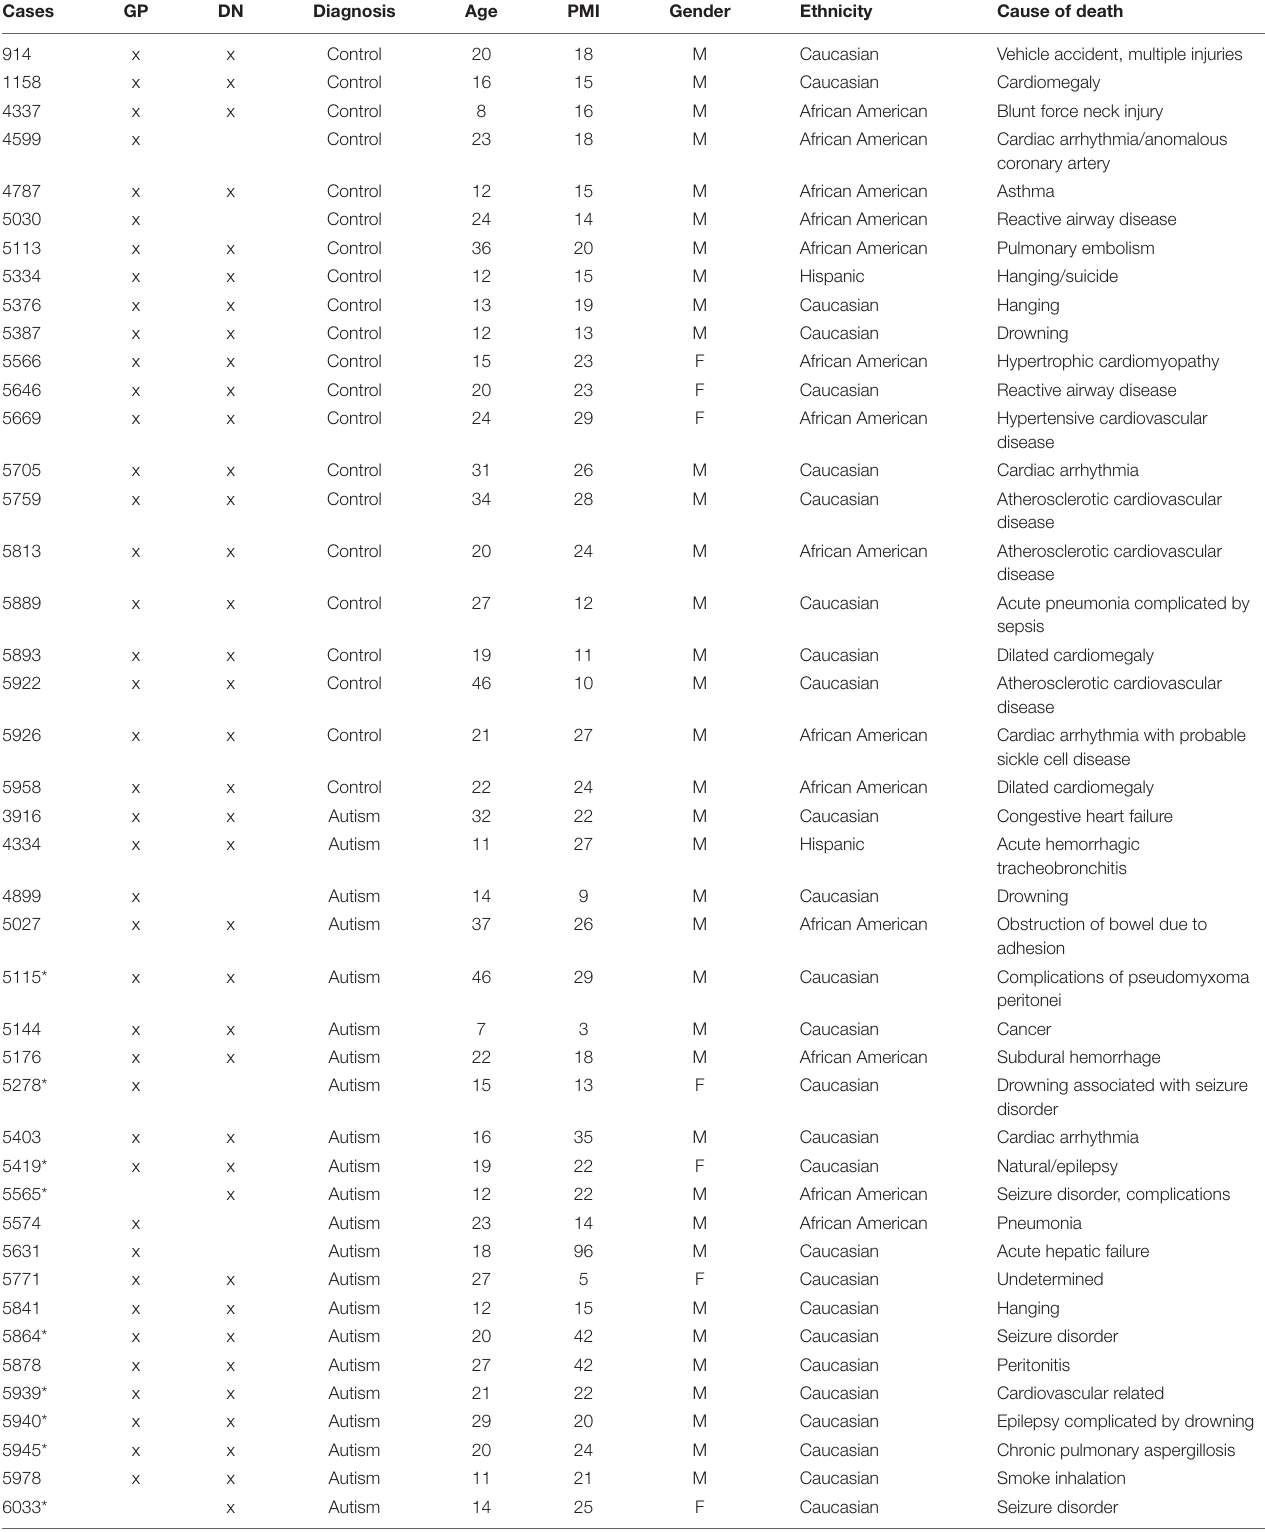
TABLE 1 | Postmortem tissue case